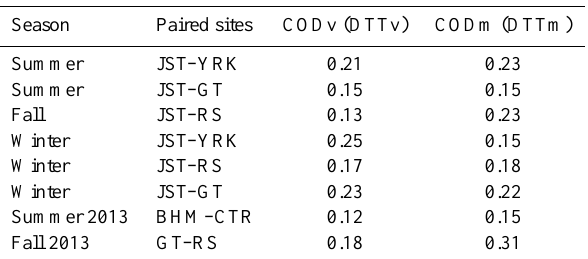
Table 3. Spatial heterogeneity of DTTv and DTTm assessed by co- efficient of divergence